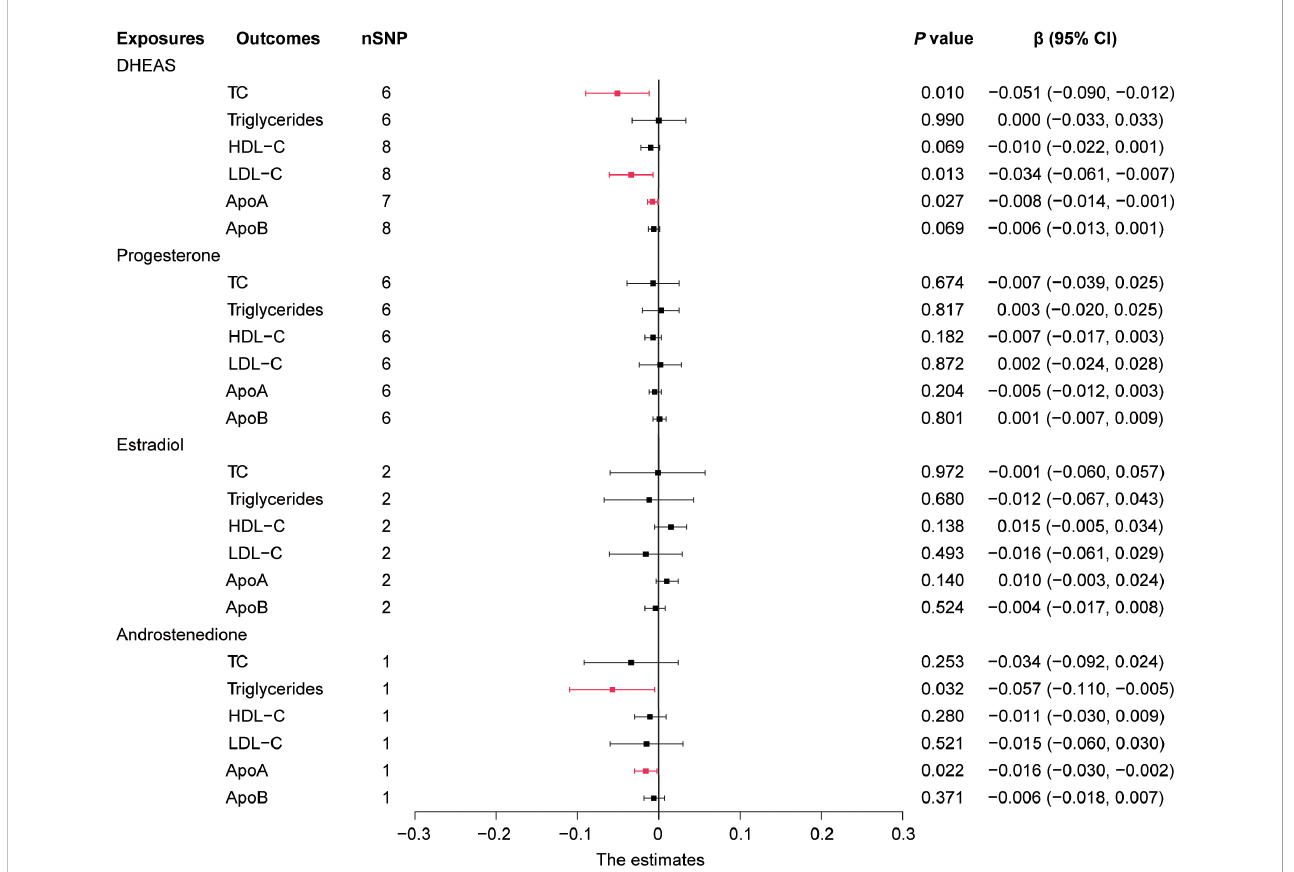
FIGURE 2 Forest plot of IVW estimates in total population. DHEAS, dehydroepiandrosterone sulfate; nSNP, number of single-nucleotide polymorphisms; HDL-C, high-density lipoprotein cholesterol; LDL-C, low-density lipoprotein cholesterol; 95% CI, 95% con fi dence interval; IVW, inverse-variance weighted; TC, total cholesterol; ApoA, apolipoprotein A ; ApoB, apolipoprotein B .